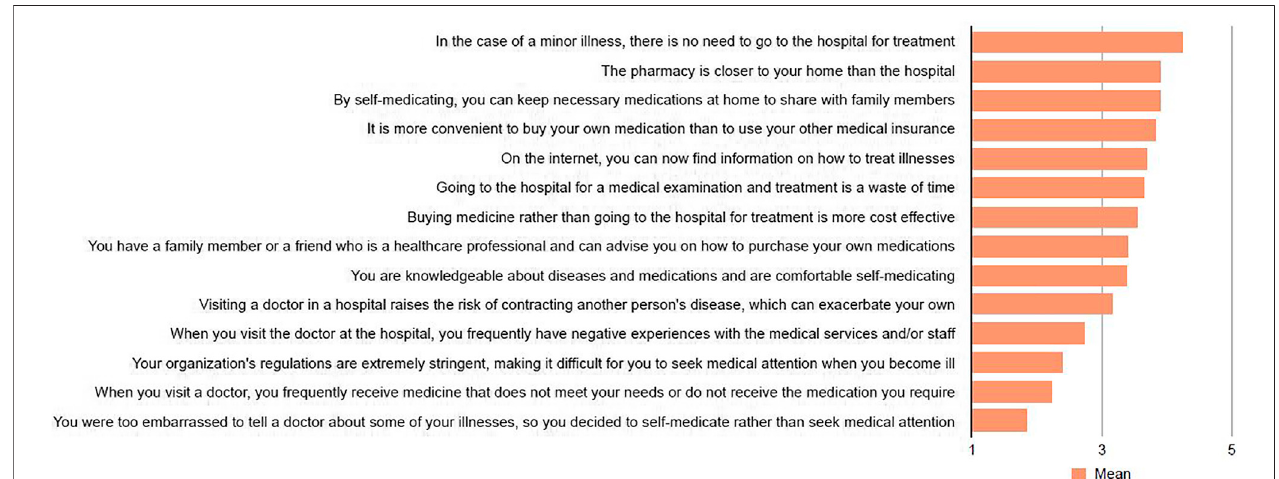
FIGURE 1 | Reasons for self-medication, Self-medication with over-the-counter medicines among the working age population in metropolitan areas of Thailand, Thailand 2021.